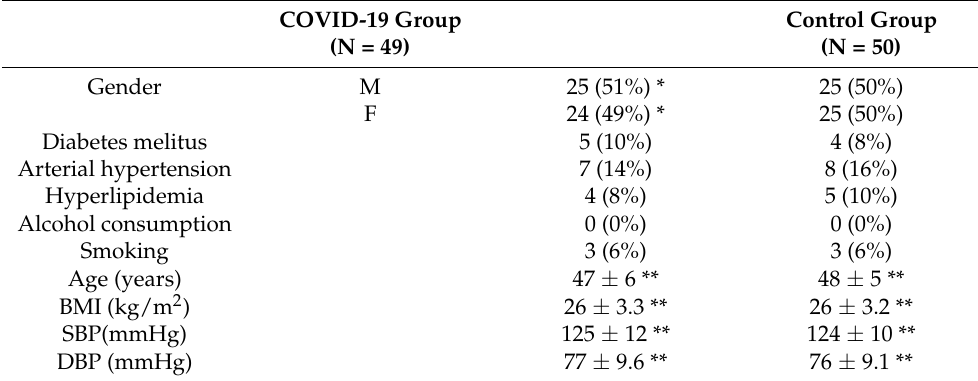
Table 2. Demographic data and some of the clinical parameters of subjects tested 300 days after the onset of COVID-19